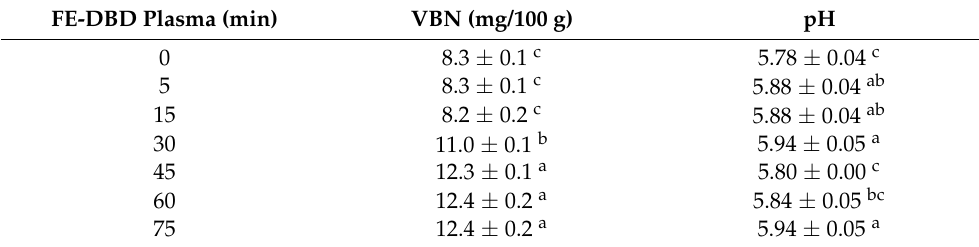
Table 5. VBN and pH of sea squirt by FE-DBD plasma treatment.